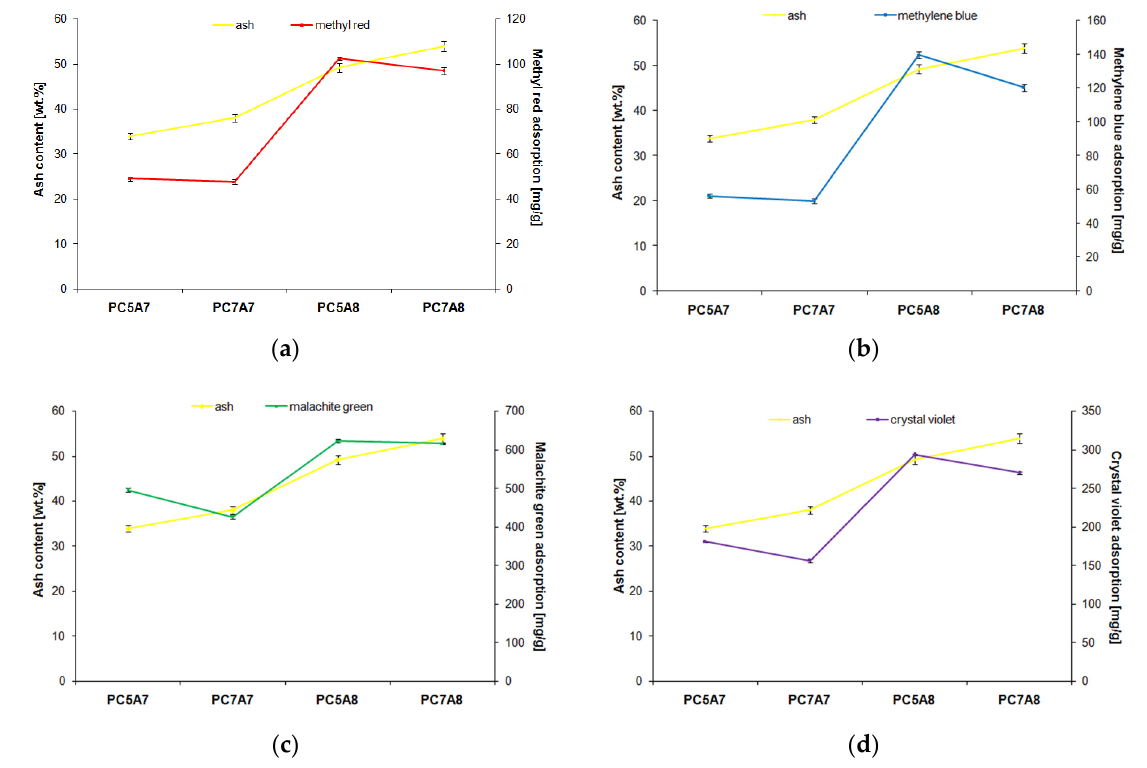
Figure 8. Dependence of carbon adsorbent s adsorption capacity on the mineral matter content for adsorption of: ( a ) methyl red, ( b ) methylene blue, ( c ) malachite green, ( d ) crystal violet.